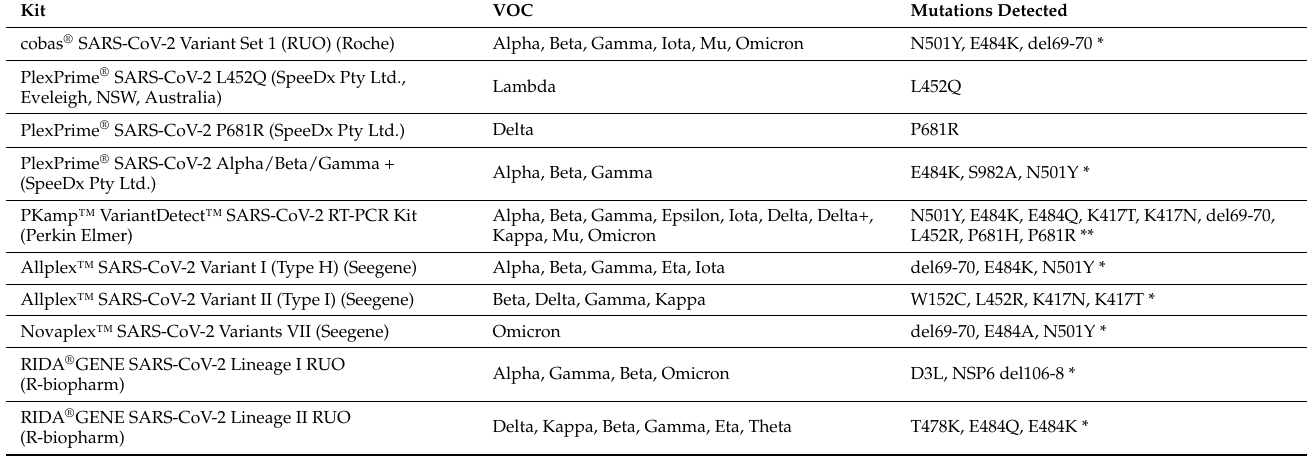
Table 1. Commercial SARS-CoV-2 variant kits (RUO) and mutations